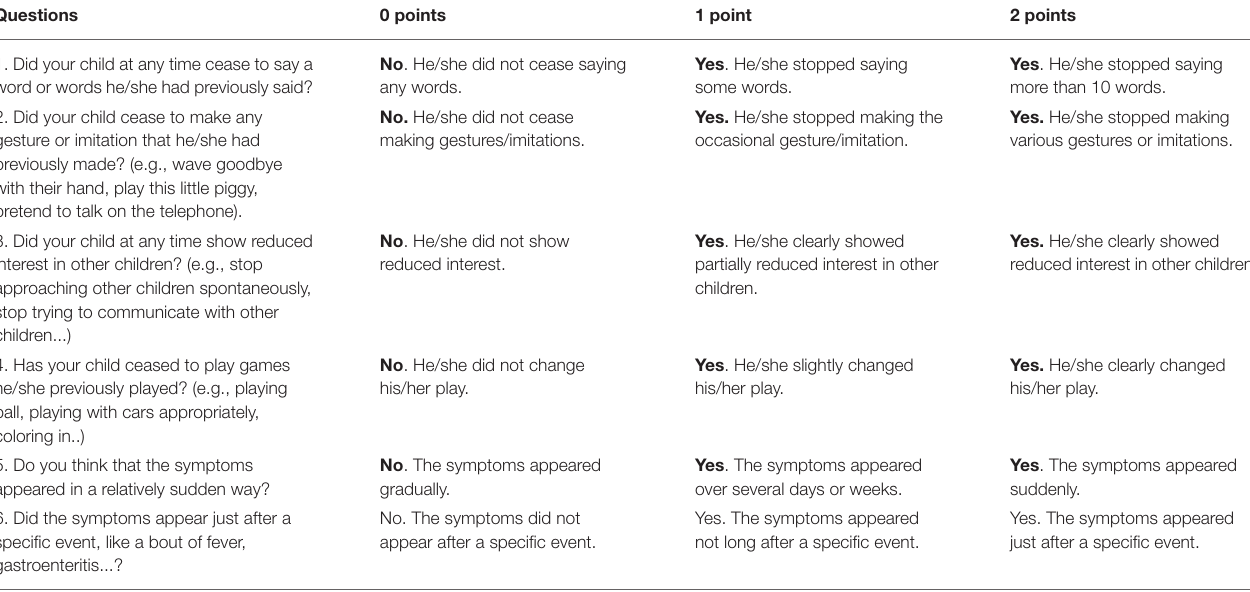
TABLE 1 | Questionnaire to classify autism spectrum disorder patients according to neurodevelopmental regression and non-neurodevelopmental regression. Questions 0 points 1 point 2 points